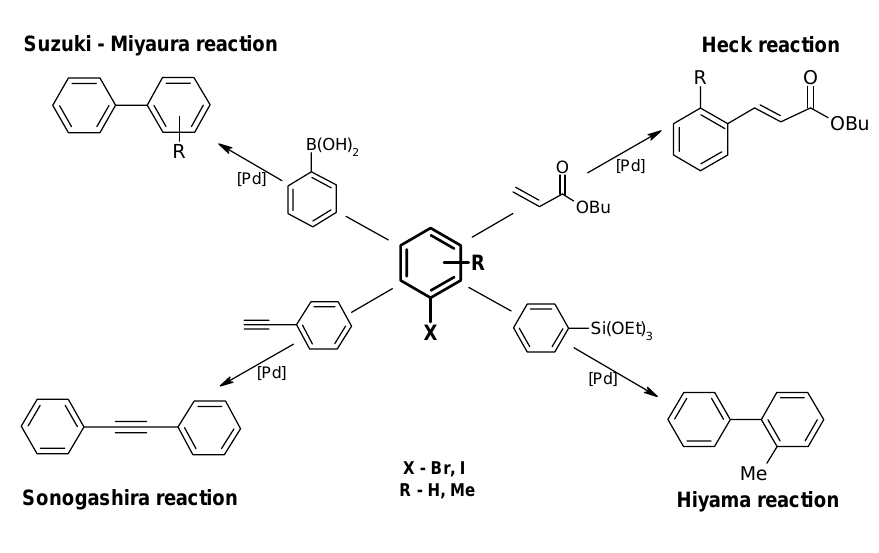
Figure 8. Scheme of studied C-C cross-coupling